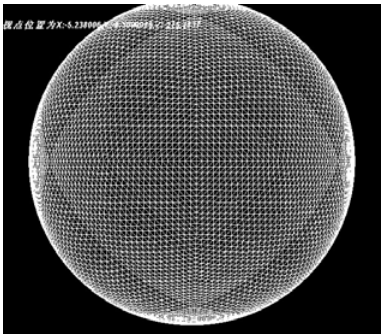
Figure 6 the partition hierarchy of QTM is six